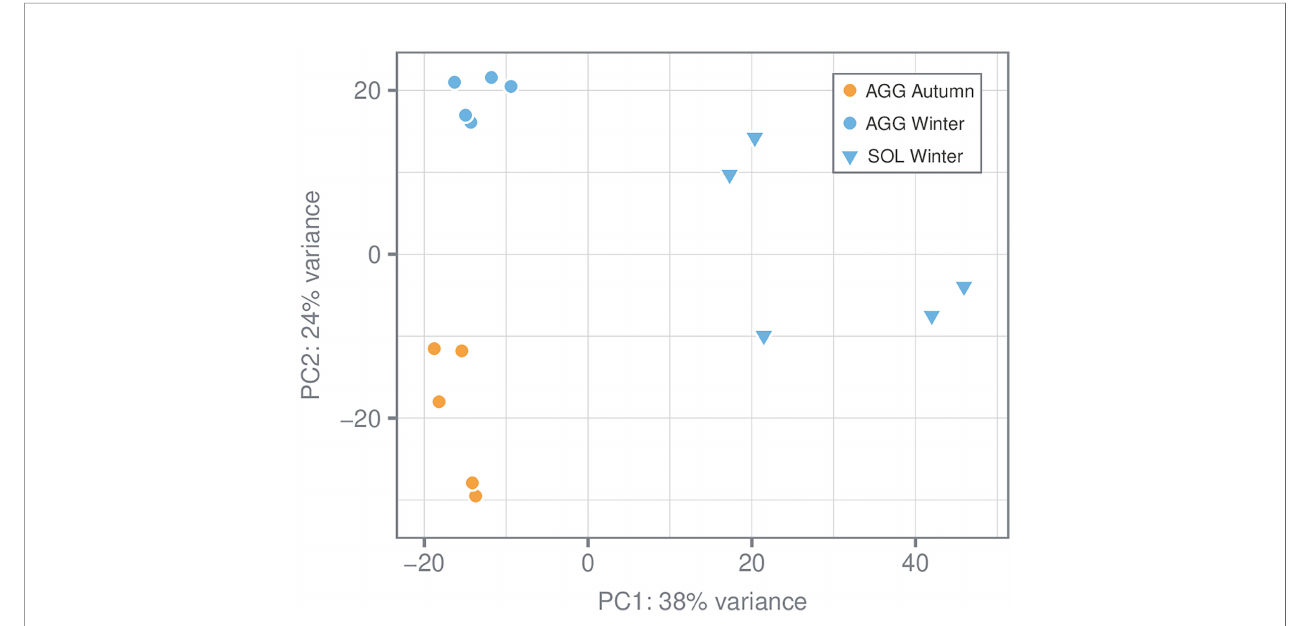
FIGURE 4 | Principal Component Analysis (PCA) of the samples analyzed from sampling campaigns (1) and (2). The PCA shows the variance- stabilized gene expression dataset containing 15 samples of S. thompsoni with each dot representing an individual sample. Different symbol colors indicate the different sampling seasons (autumn and winter, respectively), whereas different symbol shapes indicate the different forms [aggregates (AGG) and solitaries (SOL)]. The explained variance [%] for PC1 and PC2 are also